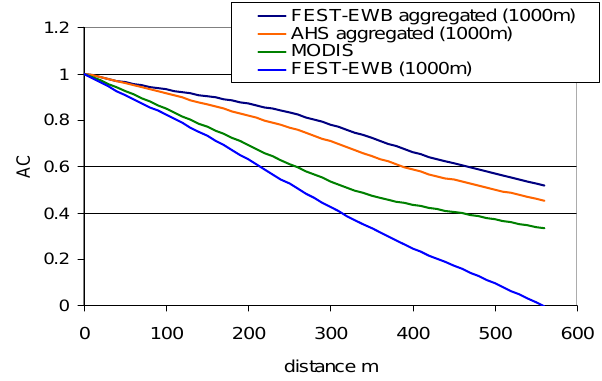
Fig. 7. Autocorrelation function for LST maps from FEST-EWB and AHS for 13 July 2005 at 13:46 at 10m of spatial resolution.